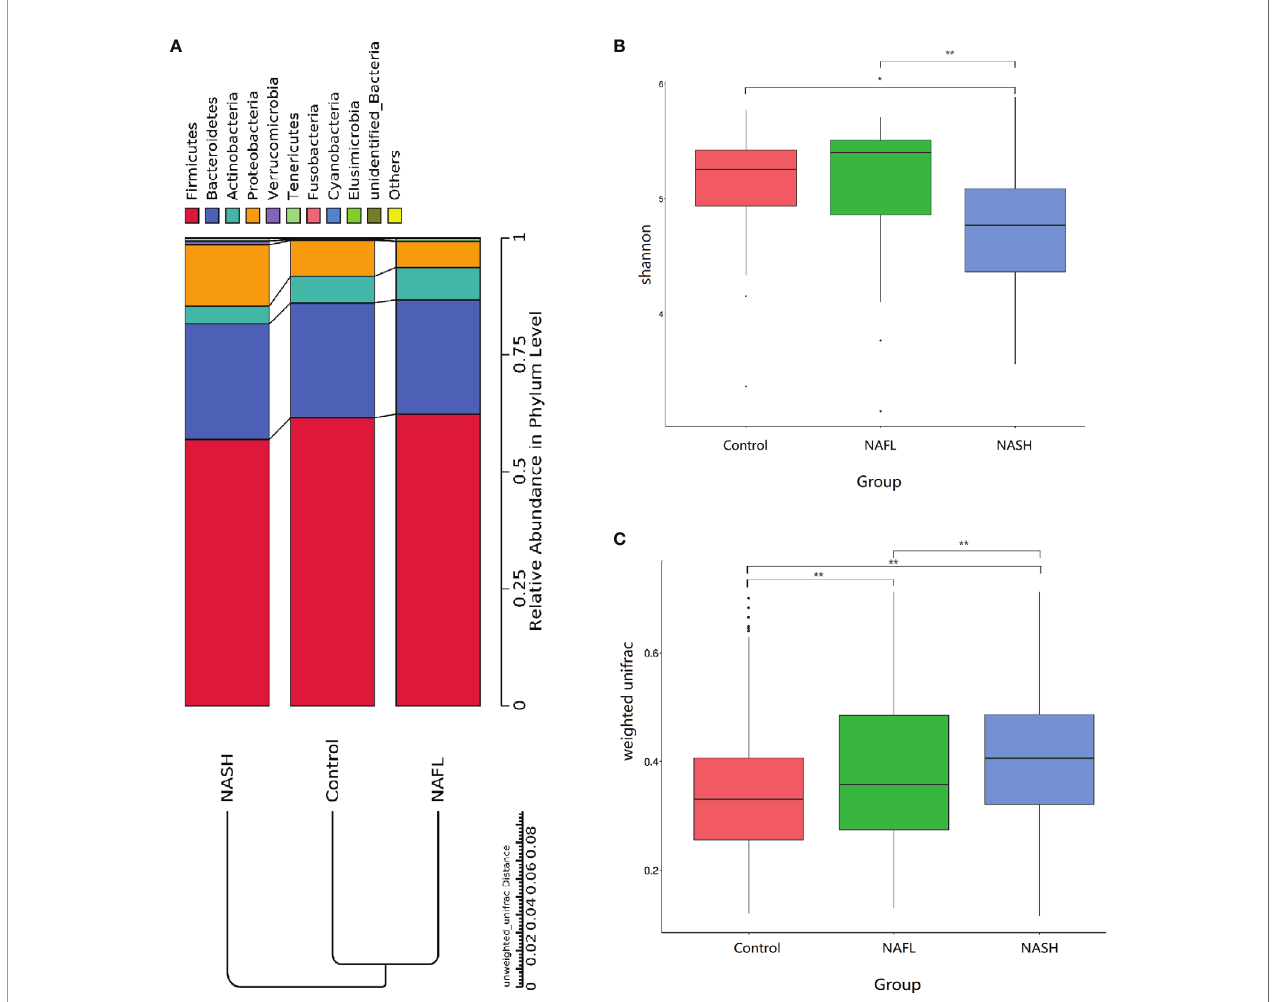
FIGURE 1 | Taxonomic composition of the bacteria. (A) The composition and relative abundance of different phyla in different groups (cluster analysis by UPGMA). (B , C) Alpha and beta diversity indices in different groups. In the analysis of differences between groups in the alpha diversity index (Wilcoxon test based on Shannon Index), the higher the Shannon index, the higher is the species diversity. In the analysis of differences between groups in the beta diversity index (Wilcoxon test based on weighted UniFrac), the higher the sample similarity index within the group, the higher is the level of difference between the different groups. NAFL, nonalcoholic fatty liver; NASH, nonalcoholic steatohepatitis. * p -value < 0.05; ** p -value <